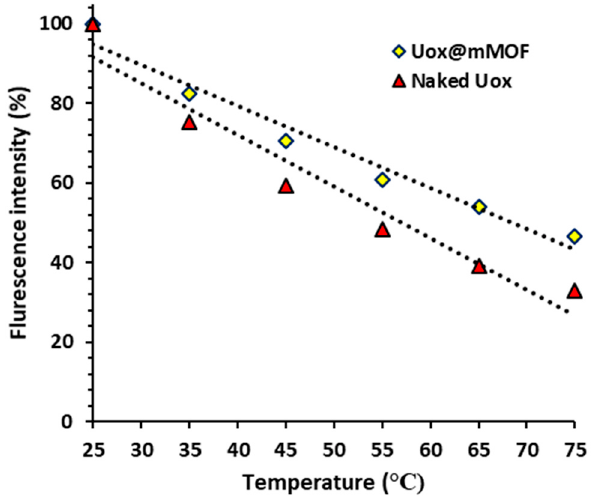
Figure 11. Internal fluorescence spectroscopy of naked and immobilized Uox. ( a ) shows the structural changes in the naked Uox against the increased temperature, and ( b ) shows the structural changes of the stabilized enzyme against the rise in temperature.